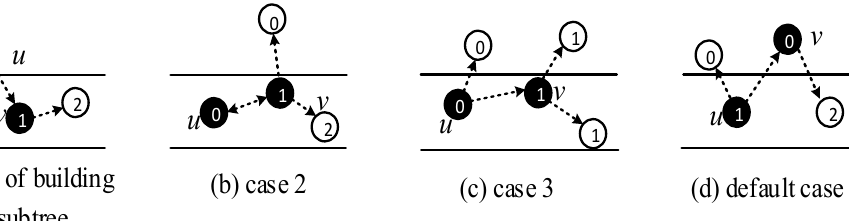
Figure 8. Building covering sub-tree. Sensors 2018 , 18 , x FOR PEER REVIEW